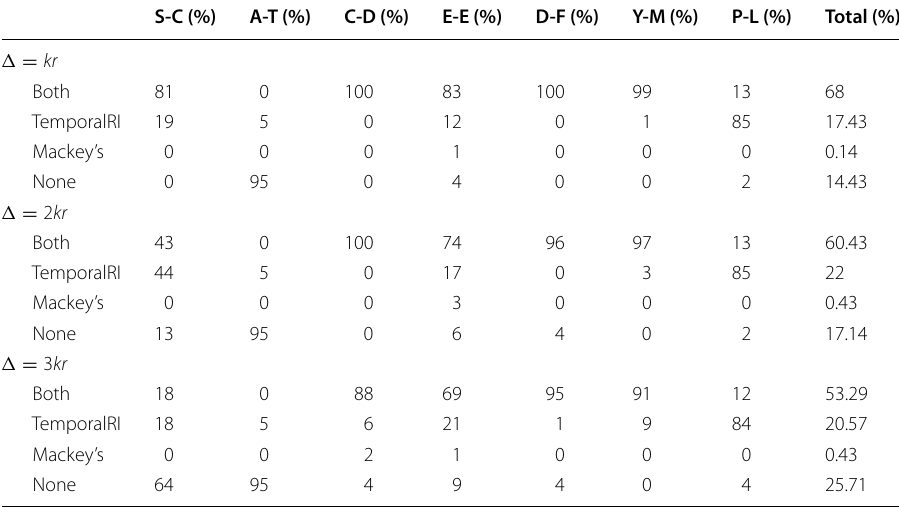
Table 4 Number of experiments with k = 9 completed by both algorithms, TemporalRI only, Mackey’s algorithm only and none of